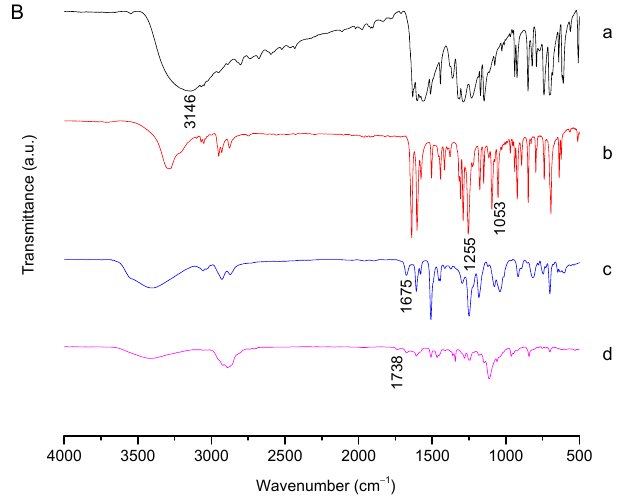
Figure 1. Characterization of Bi(mPEG-S-S)-TPE. ( A ) 1 H NMR spectra of ( a ) HBP, ( b ) HEBP, ( c ) HO-TPE-OH, and ( d ) Bi(mPEG-S-S)-TPE. ( B ) FT-IR spectra of ( a ) HBP, ( b ) HEBP, ( c ) HO-TPE-OH, and ( d ) Bi(mPEG-S-S)-TPE.